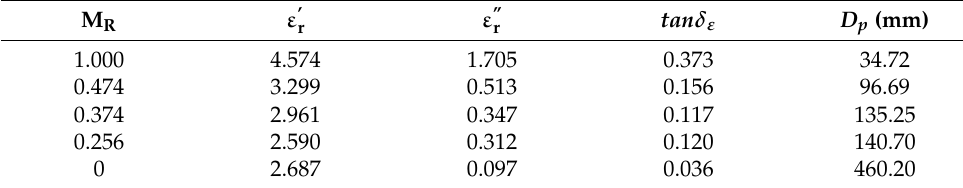
Table 3. Variation of permittivity of CRES with moisture